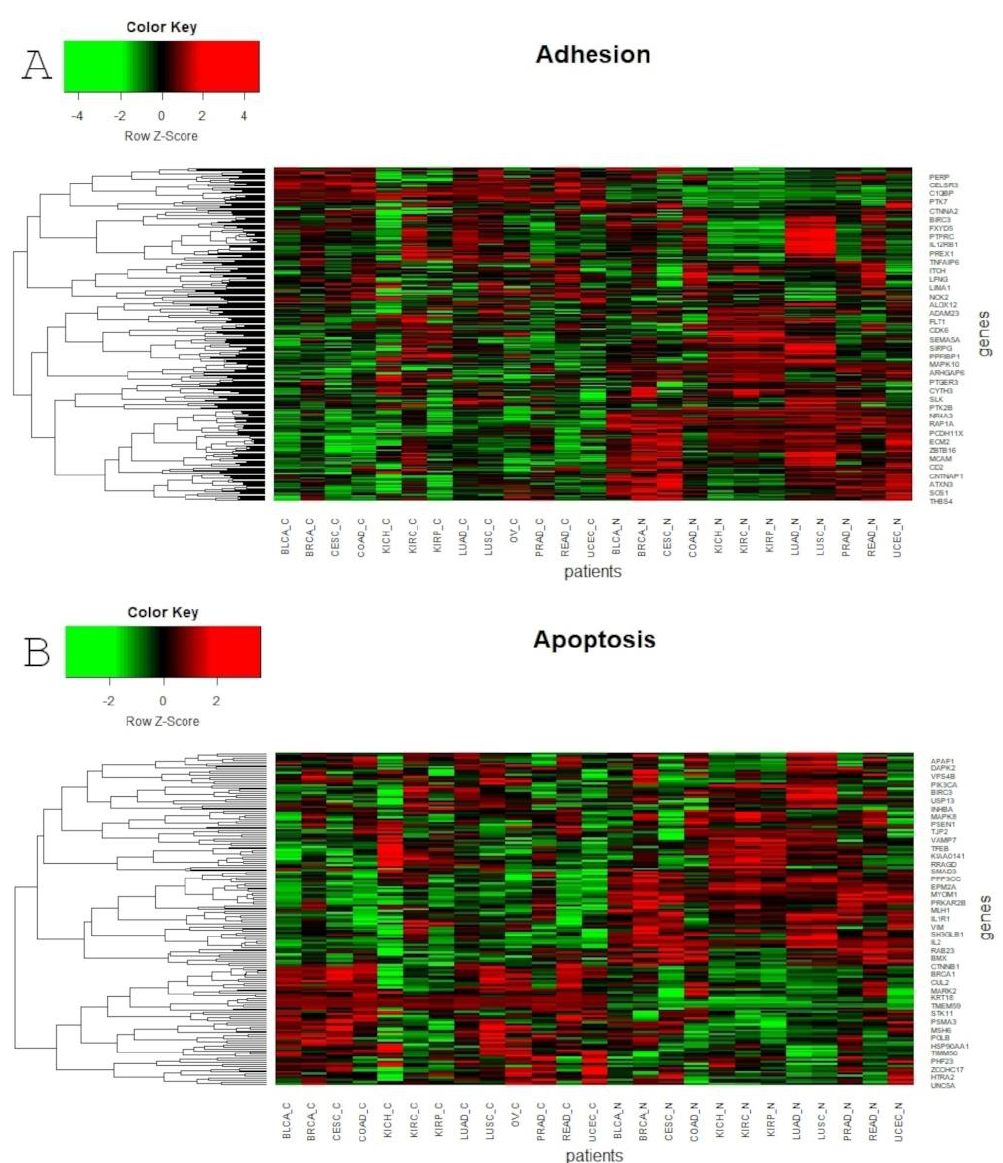
Figure 5. Heatmap reflecting differential median gene expression of Notch target genes in the analyzed cancerous and normal tissues. Target genes are grouped into four biological processes: ( A ) Adhesion; ( B ) Apoptosis.